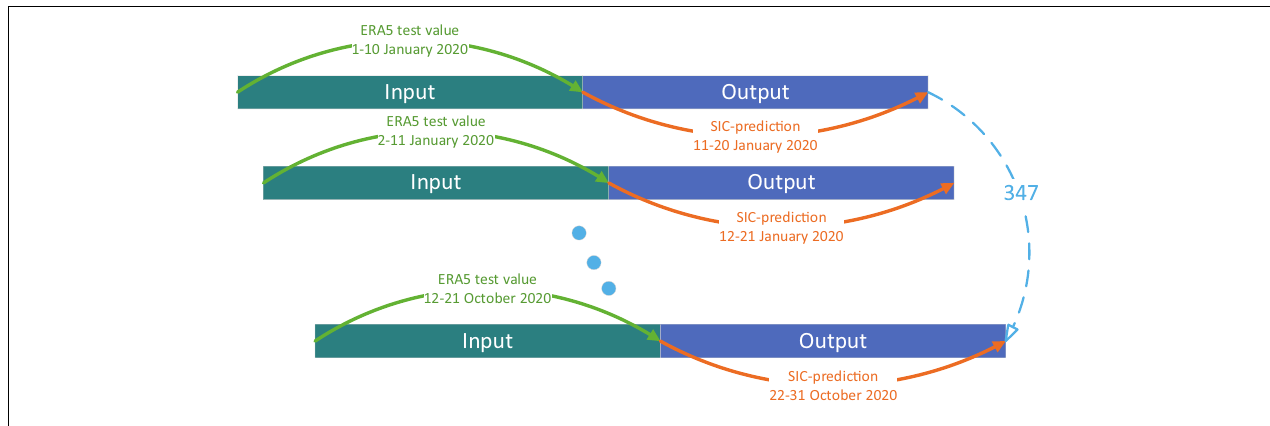
FIGURE 2 | Date of model test input and